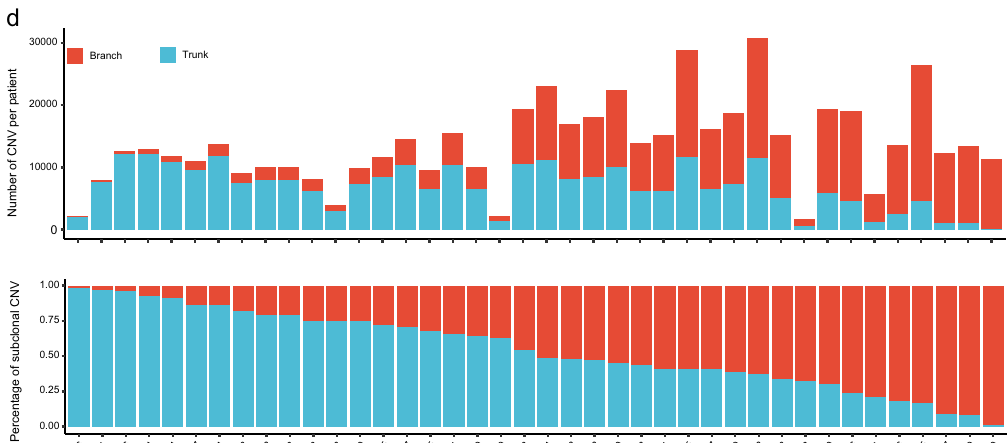
Fig. 2 Copy number alterations in our cohort. a Arm level CNVs identi fi ed by GISTIC2.0 in SCLC ( n = 40). False discovery rate (FDR) corrected p value represents signi fi cant changes from Benjamini – Hochberg testing. b The genome chromosome plots depict signi fi cant cytobands identi fi ed by GISTIC2.0. c The signi fi cant somatic focal CNVs of pure SCLC and combined lung cancer are shown for each region of the individual patient. Cytobands with genes involved in cosmic drivers and those that occurred in at least 50% of patients are shown. d Counts in the trunk and branch of CNVs for each patient; Percentage of branch CNVs for each patient ( n = 40). SCLC small cell lung cancer, Amp ampli fi cation, Del deletion, CNVs copy number